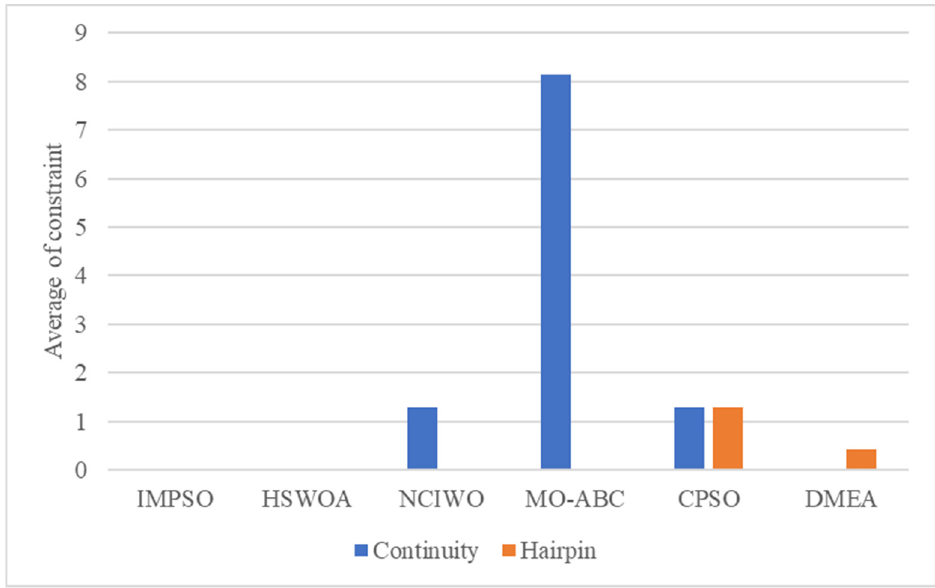
Figure 2. Comparison results among average values of IMPSO, HSWOA, NCIWO, MO-ABC, CPSO, DMEA and IMPSO in continuity and hairpin.